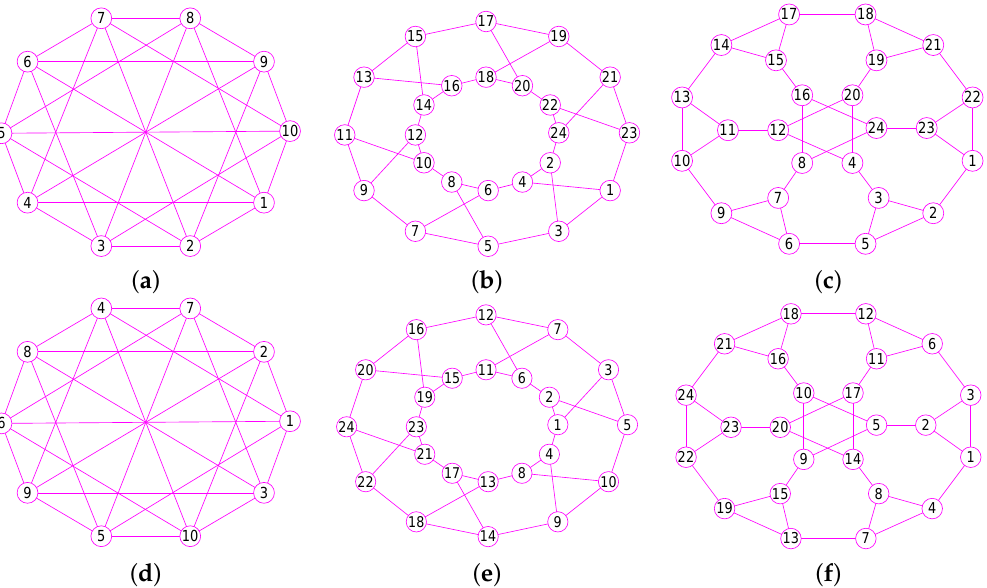
Figure 15. The TopMost graphs of three graphs K ( 5,5 ) , G 17 and G 18 . ( a ) The complete bipartite graph K ( 5,5 ) of 10 vertices and 25 edges; ( b ) The 12-crossed prism graph G 17 of 24 vertices and 36 edges; ( c ) The 6th order cube-connected cycle graph G 18 of 24 nodes and 36 edges; ( d ) The TopMost graph of K ( 5,5 ) ; ( e ) The TopMost graph of G 17 ; ( f ) The TopMost graph of G 18 .